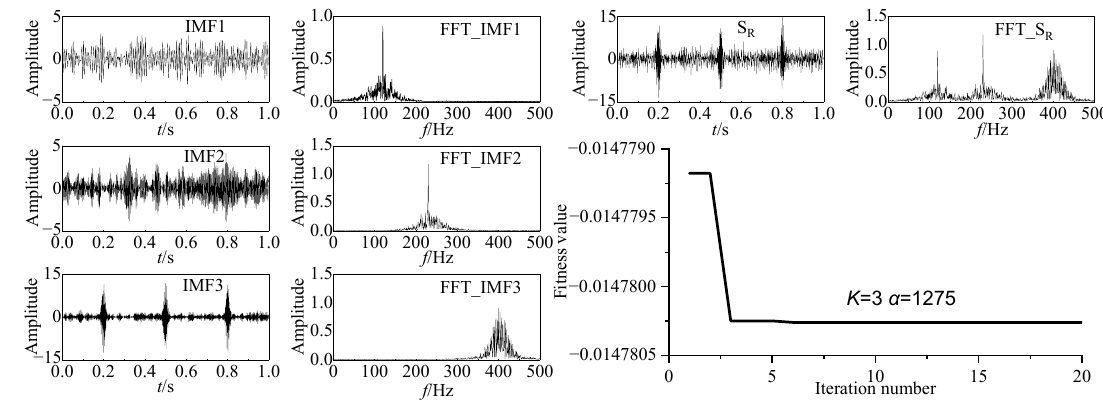
Figure 2. Simulated signal.